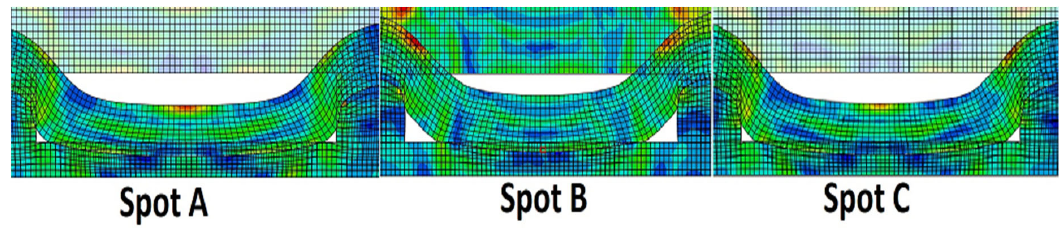
Figure 17. Deformed and undeformed shapes of the samples.